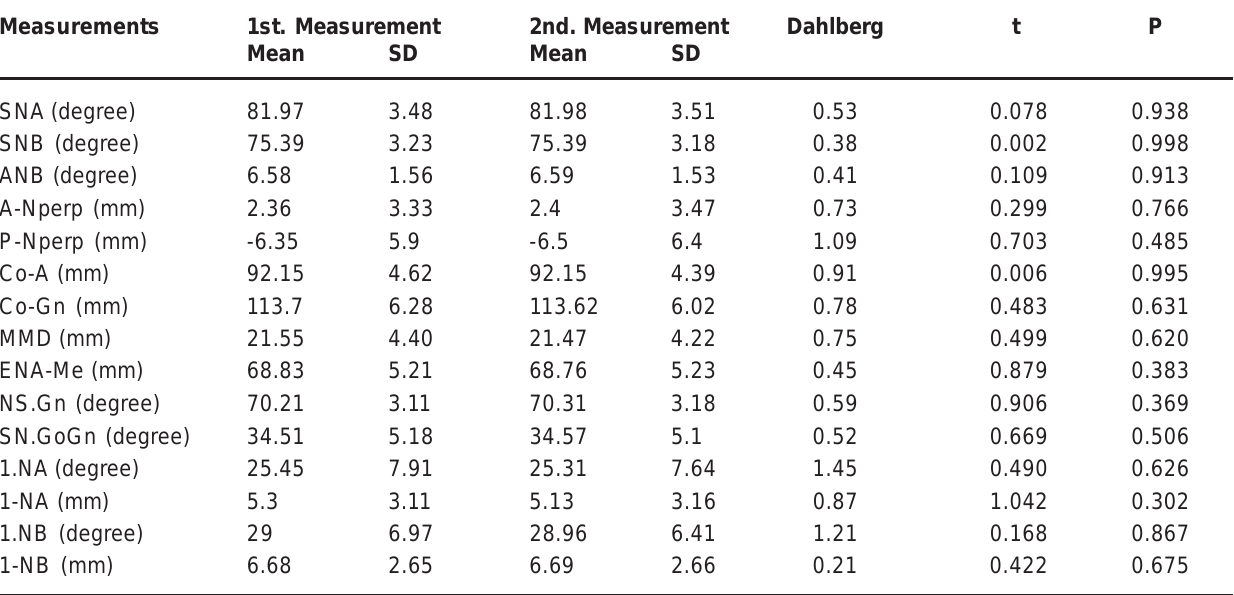
TABLE 1- Casual and systematic errors for the studied